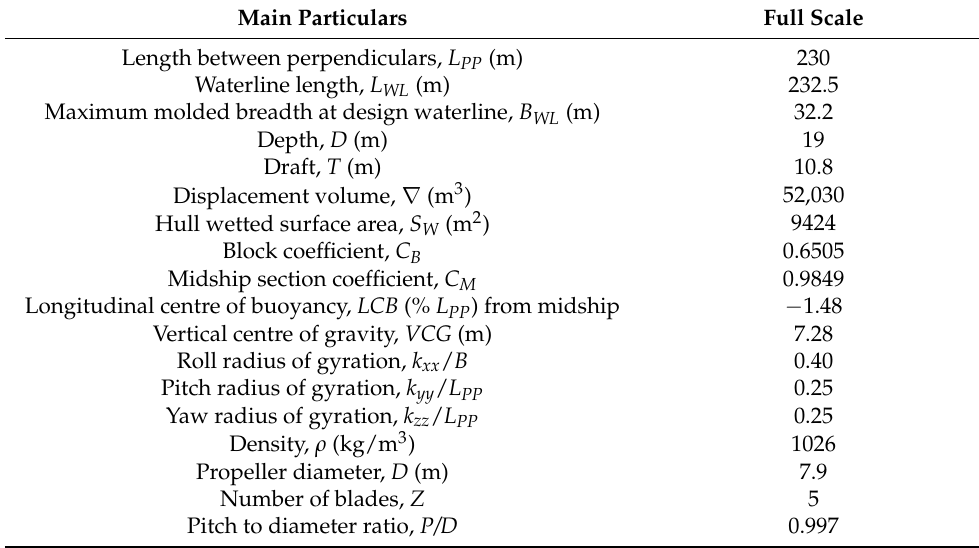
Table 1. The main particulars of KCS. Main Particulars Full Scale Length between perpendiculars, L PP (m) 230 Waterline length, L WL (m) 232.5 Maximum molded breadth at design waterline, B WL (m) 32.2